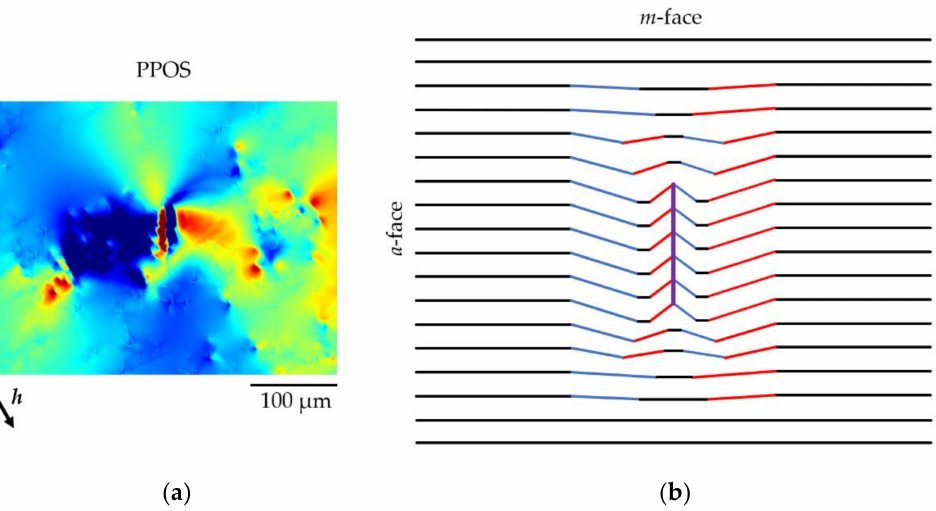
Figure 15. Lattice plane rotations around a limited size subgrain boundary; ( a ) RCI PPOS measure- ment of the lattice rotation; ( b ) schematic drawing: black lines—no rotation of the lattice planes, blue lines—downward rotation of the lattice planes, red lines—upward rotation of the lattice planes, and purple line—limited size subgrain